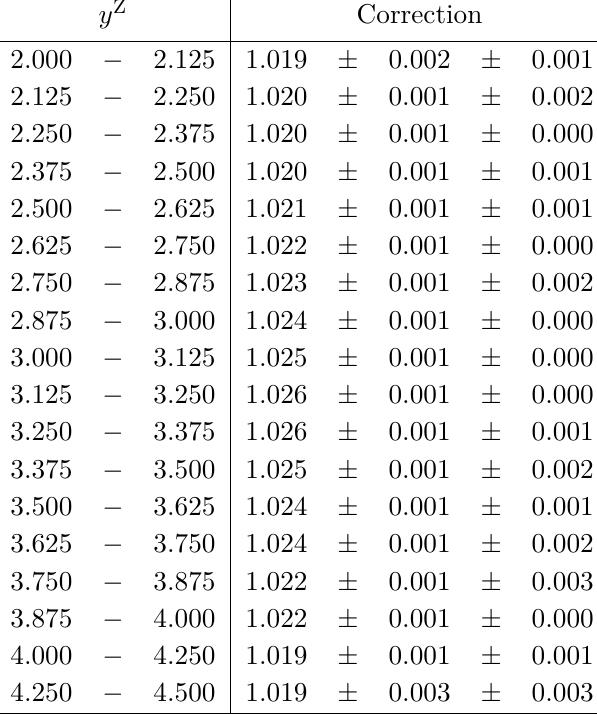
Table 2 . Final state radiation correction used in the y Z cross-section measurement. The first uncertainty is statistical and the second is